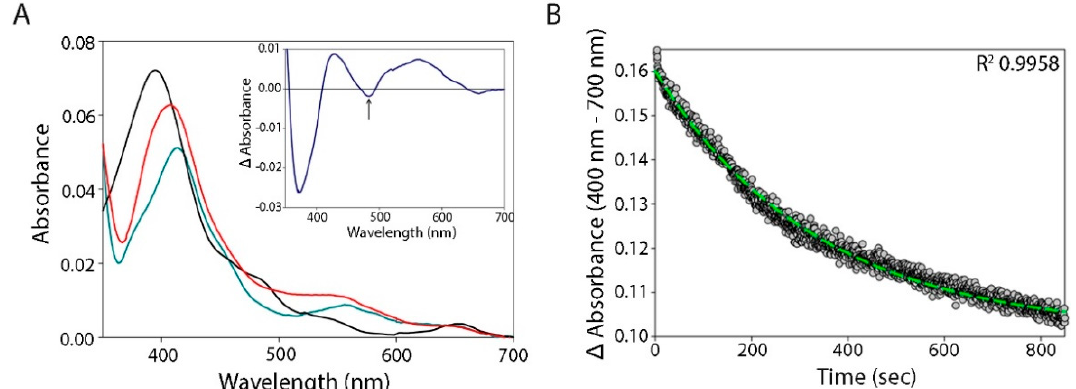
Figure 2. eNOS reduction. ( A ) Spectra for full-length Fe 3+ eNOS (black line), after the addition of NADPH (red line) or with sodium dithionite (cyan line), under anaerobic conditions. The red spectrum is simulated as a combination of 40% ferric and 60% ferrous eNOS. The insert shows the differential spectrum for the oxygenase domain redox transition of the full-length eNOS after addition of NADPH, which also involves flavin reduction in the reductase domain (485 nm, black arrow). ( B ) eNOS reduction kinetics in the presence of cofactors and L-arginine after mixing NADPH under anaerobic conditions. The dashed lines represent the exponential rise fit with the associated determination coefficient (R 2 ).